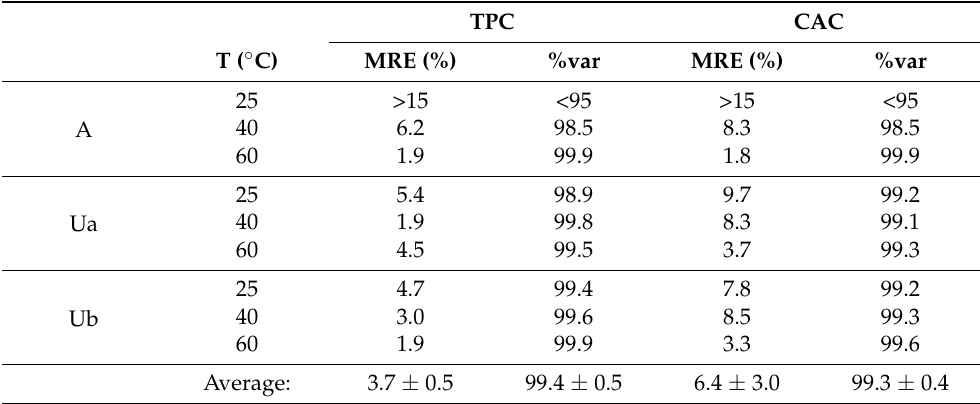
Table 3. Mean relative error (MRE) and percentage of explained variance (%var) estimated by comparison of experimental and simulated extraction kinetics of total phenolic content (TPC) and chlorogenic acid content (CAC) from artichoke stem slabs (0.5 cm thickness) at different temperatures with agitation (A) and ultrasound assistance (Ua, 200W/L and Ub, 335 W/L).